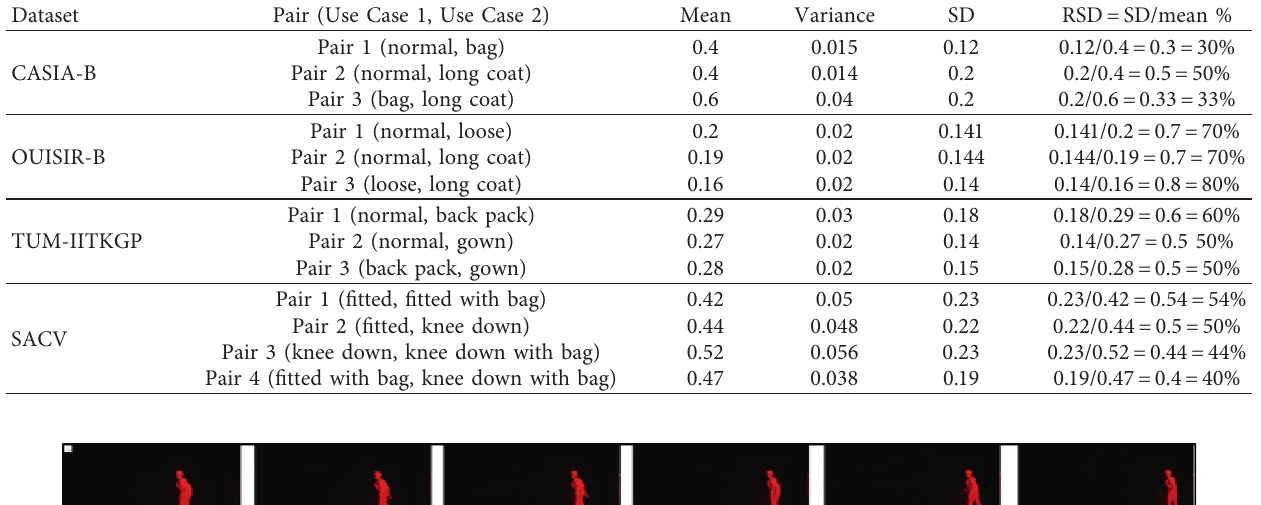
Table 3: Standard deviation and relative standard deviation score of CCS for gait verification. Dataset